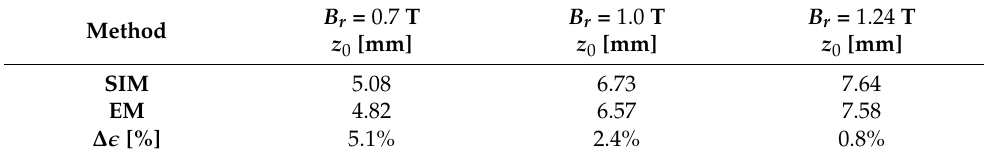
Table 5. The influence of the MF’s remanence flux density ( B r ) on the PM’s equilibrium